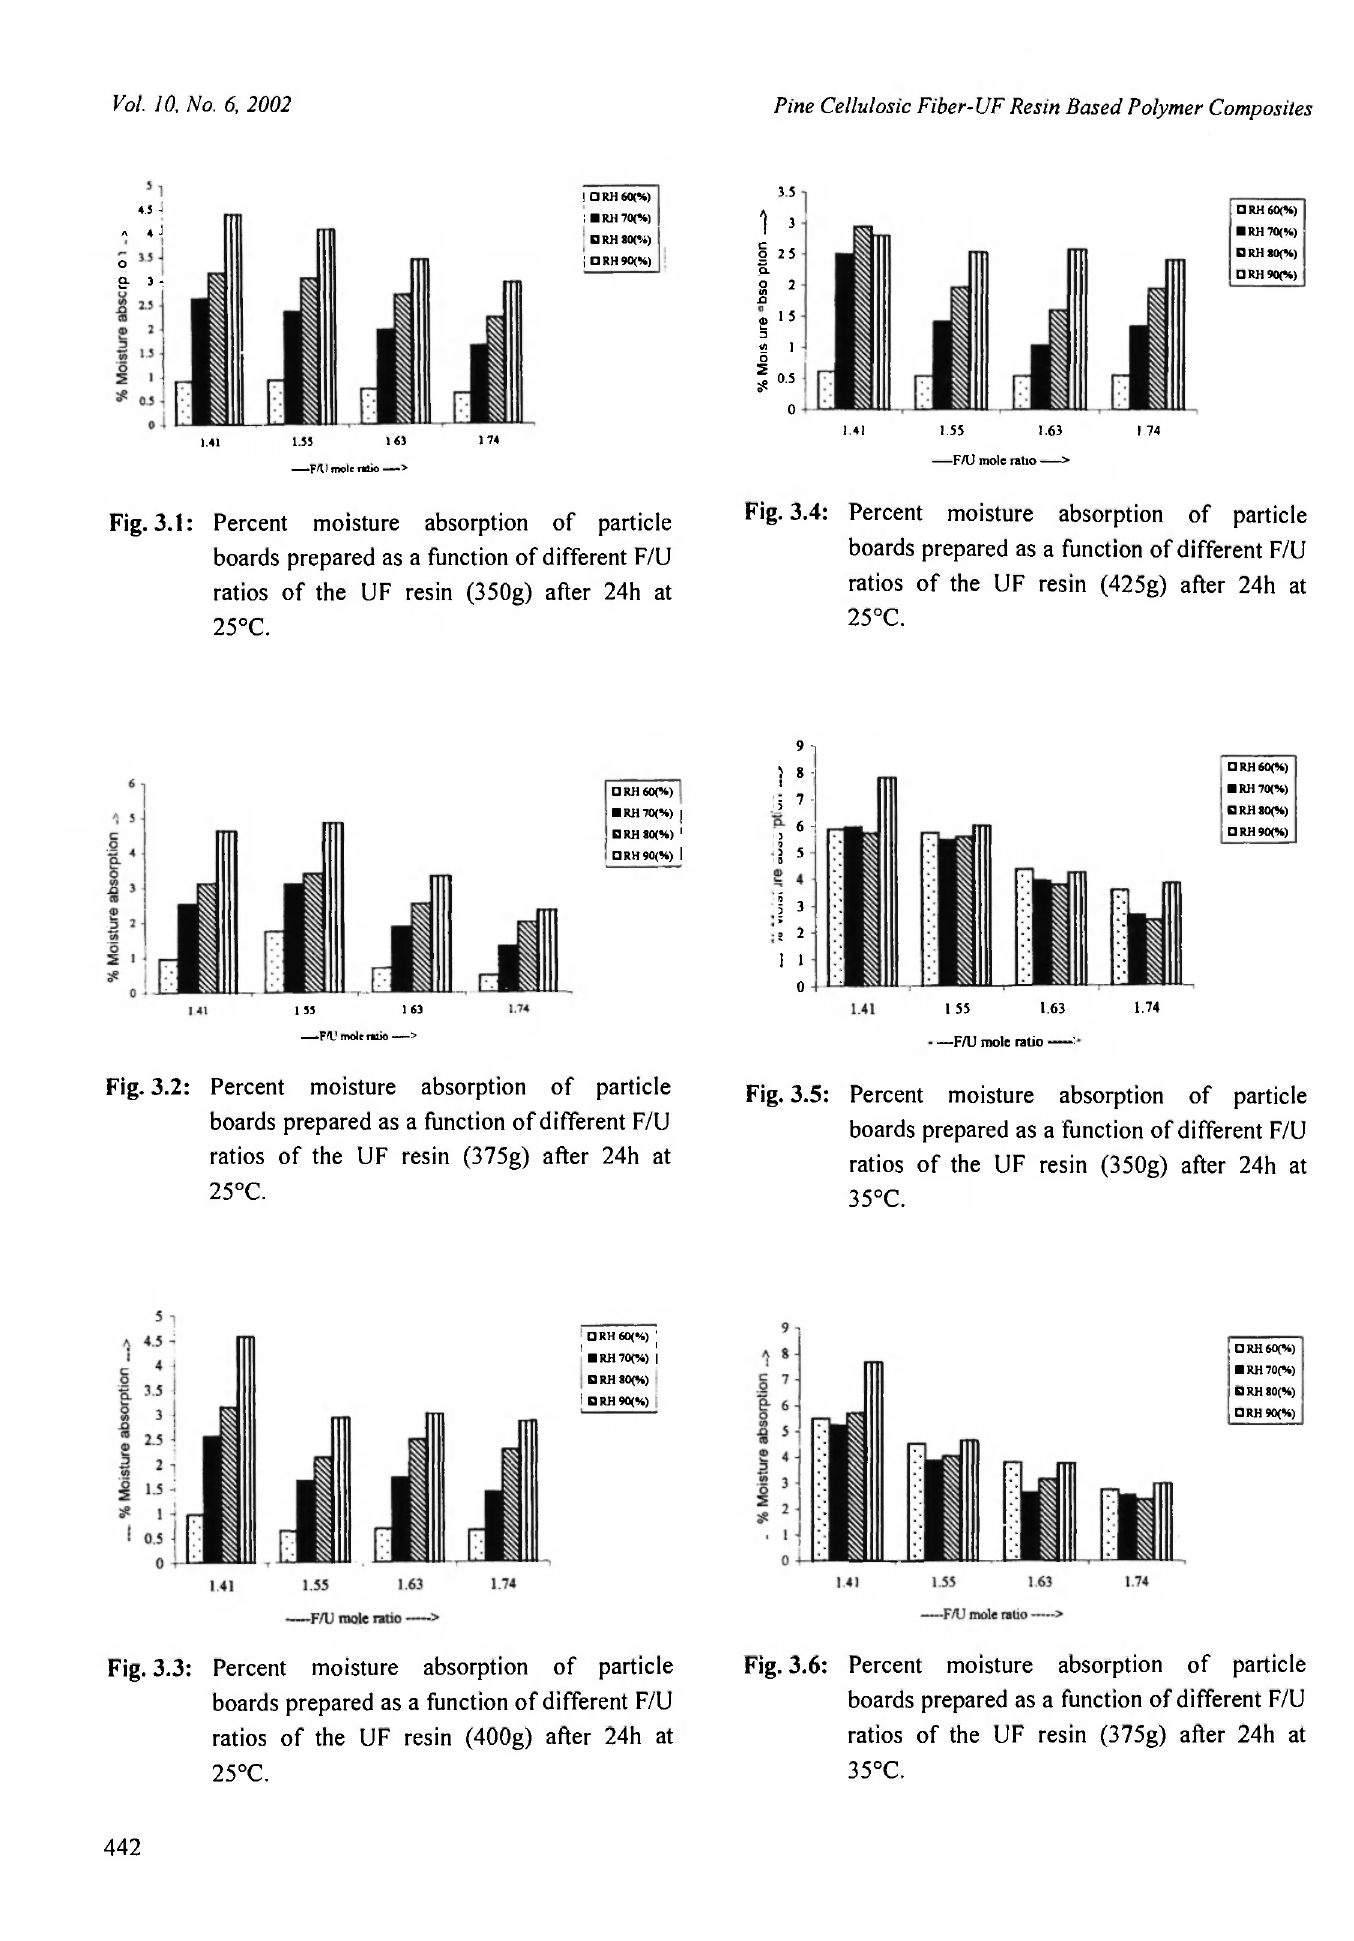
Fig. 3.6: Percent moisture absorption of particle boards prepared as a function of different F/U ratios of the UF resin (375g) after 24h at